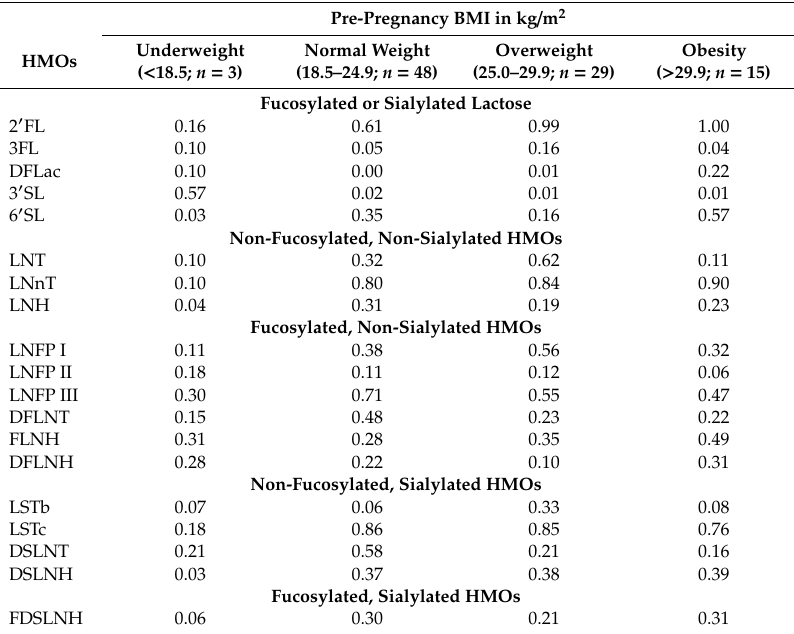
Table 7. NMF scores according to pre-pregnancy BMI for individual HMOs.